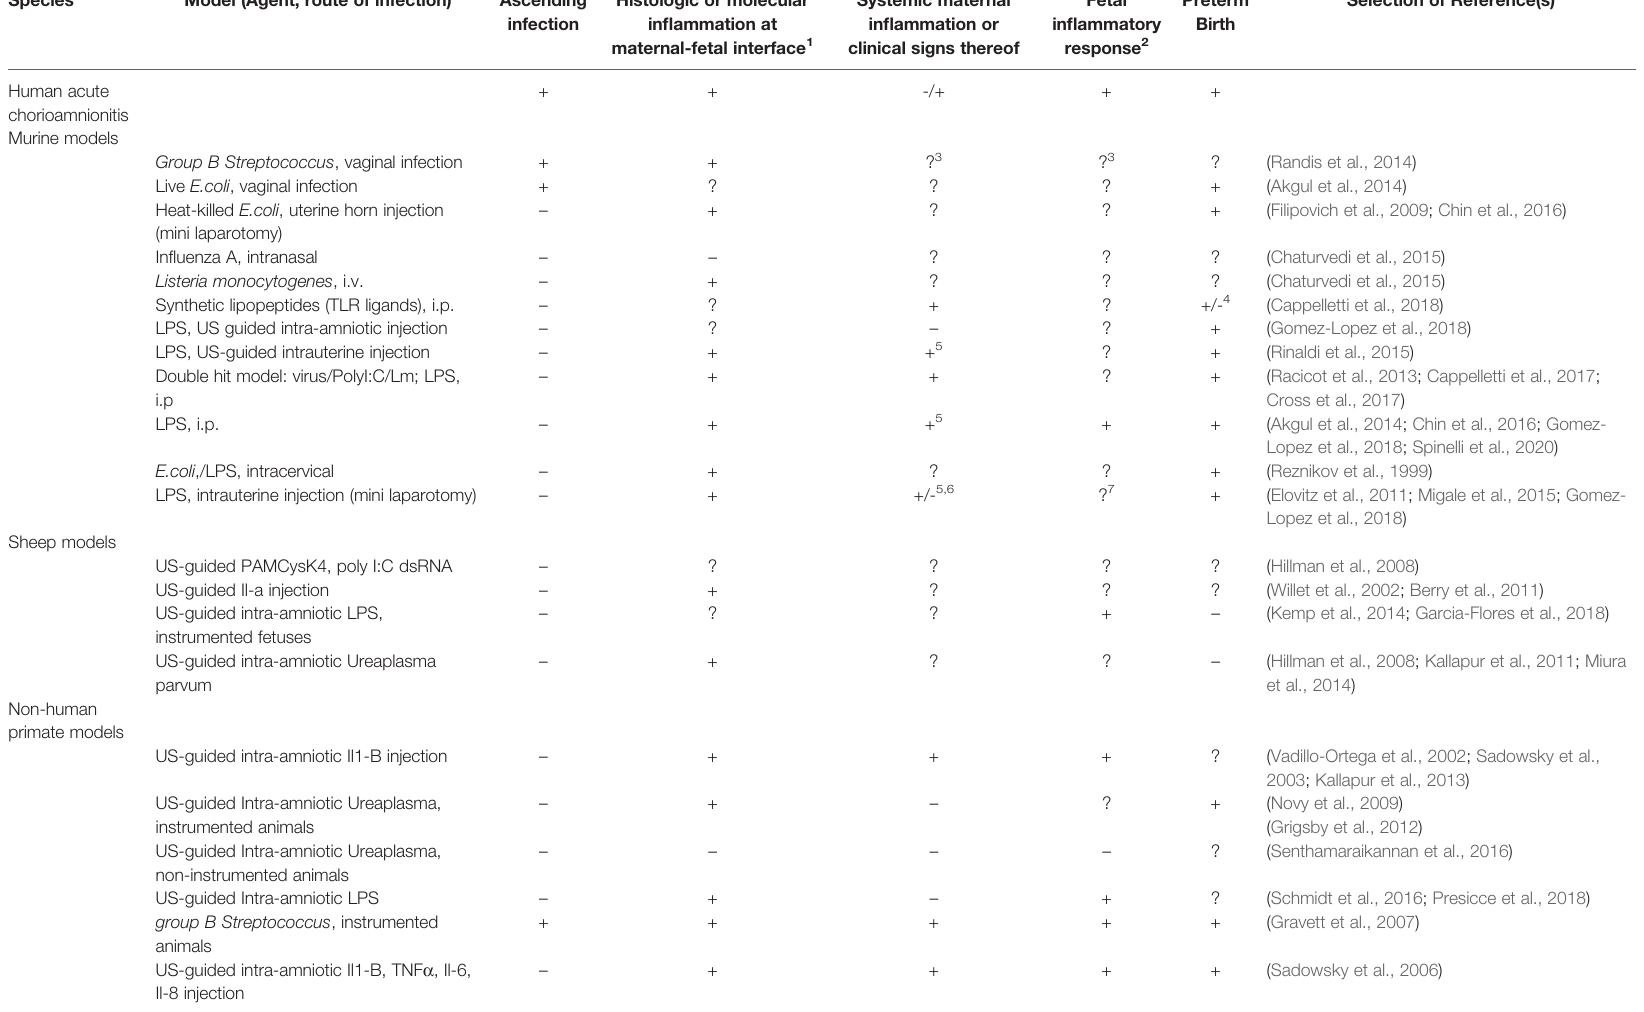
TABLE 1 | Summary of characteristics of different animal models of acute chorioamnionitis. Species